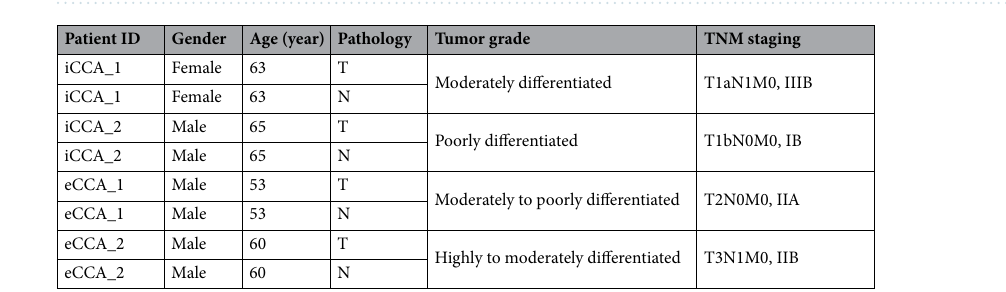
Figure 6. Immunohistochemistry staining of SCP2 and UBIAD1 on 2 iCCA cases and 2 eCCA cases. N represents for noncancerous tissue and T for tumor specimen.